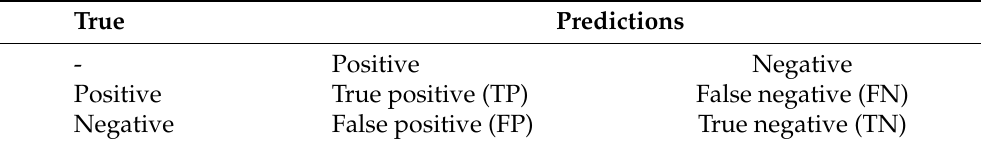
Table 2. The confusion